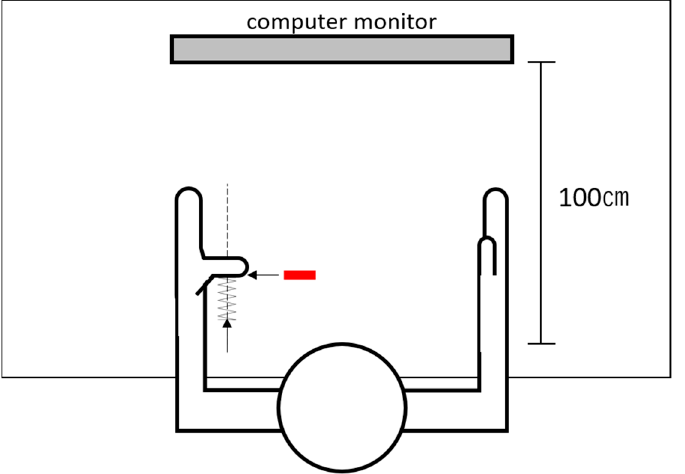
Figure 2. Schematic diagram of the spring device (the left hand as an example). The experimenter pushed the spring device along the vertical trajectory (the dotted line), passing the thumb inter- phalangeal joint, gradually applying force against the participant’s fully abducted thumb. If the stable electromyographic recording of 50% ± 10% maximum voluntary conTable 50. ± 10% MVC output of the bilateral APB. After the participants managed to maintain 50% ± 10% MVC with visual feedback, feedback alternation procedures were performed subsequently. When the participants reached maximum thumb abduction without force output, the experimenter pushed the spring device along the vertical trajectory passing the thumb IP joint, gradually applying force against the participants’ fully abducted thumb. The participants were instructed to maintain maximum abduction while the spring force was gradually applied to the thumb IP joint. If stable EMG recording of 50% ± 10% MVC appeared on the screen, the bottom of the spring device was then fixed on the desk, and a red sign was attached to the desk at the place that was covered unseen by the participants beneath their thumb. In the main experiment, the participants were instructed to ‘abduct the thumb fully and press against the spring device, covering the red sign to keep the optimal muscle output’ to maintain 50% MVC muscle output when